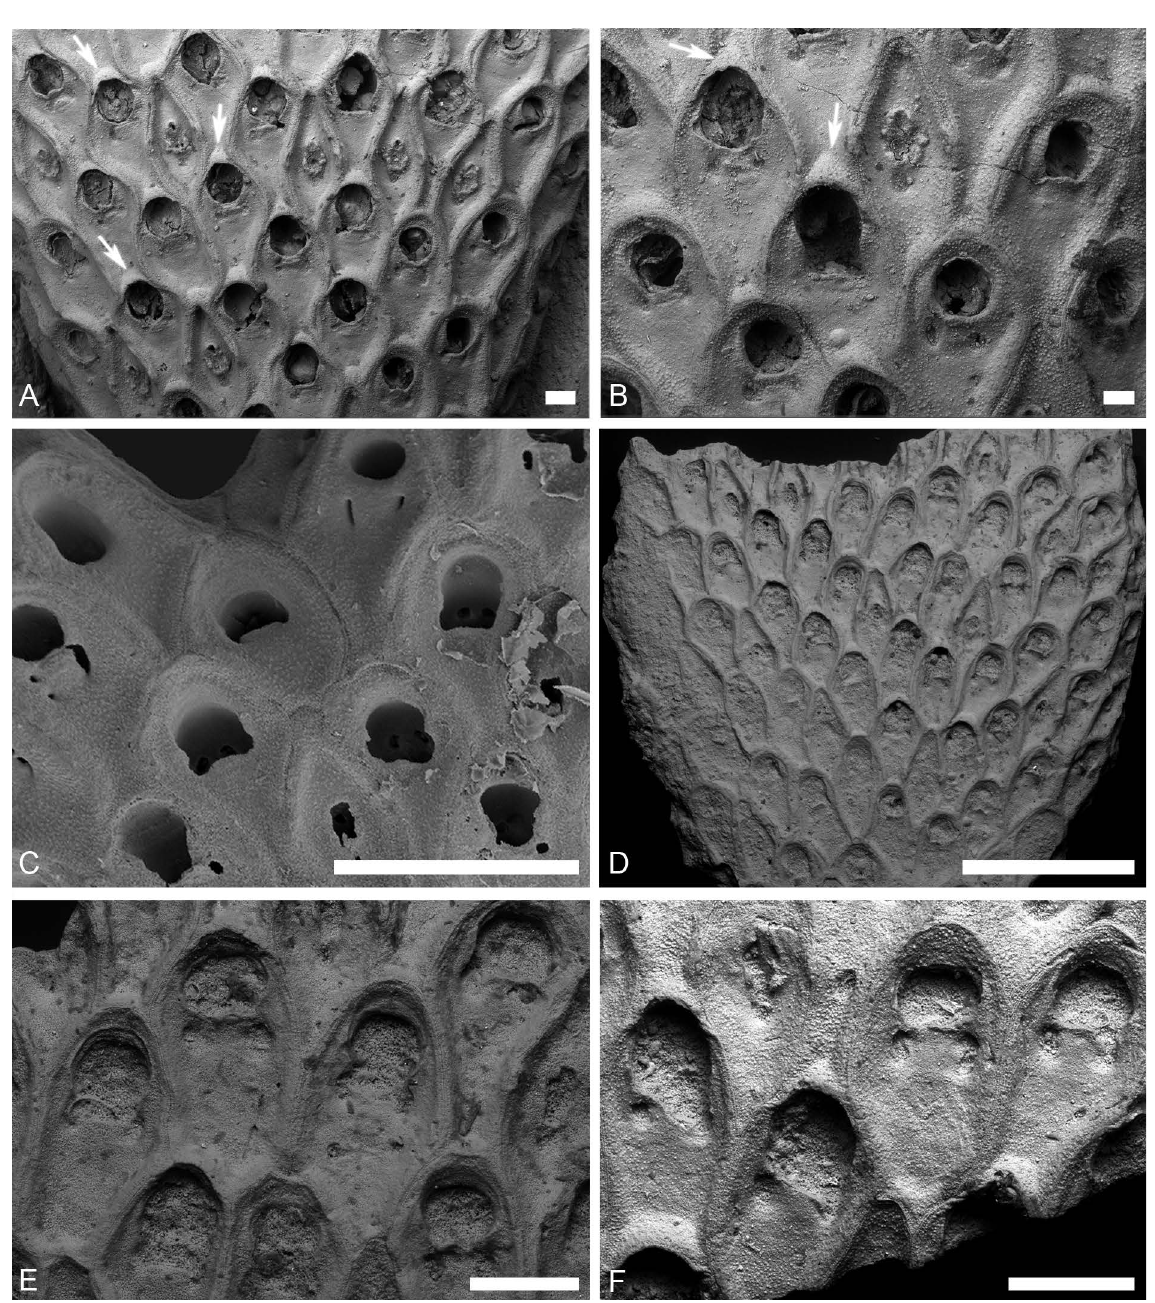
Fig. 19. Rhagasostoma mimosa (Brydone, 1930). A–B . Lectotype, SM B36696, early Maastrichtian ( Ostrea lunata Zone), Porosphaera Beds of Trimingham, Norfolk, England, UK. A . Part of erect bifoliate colony showing ovicellate (some ooecia arrowed) and non-ovicellate autozooids and aviacularia. B . Detail of autozooids with opesiules and some with vestigial ooecia (arrowed), and avicularia. C . SMF 29923, early Maastrichtian, Island of Møn, Denmark, bifurcating colony showing autozooids some opesiules and avicularia. D–F . Early Maastrichtian of an unknown locality on the Mangyshlak Peninsula, Mangystau Region, Kazakhstan. D–E . PIN 5502/3057. D . Part of erect bifoliate colony showing autozooids and aviacularia. E . Detail of autozooids with opesiules and avicularia. F . PIN 5502/3056, autozooids with opesiules and avicularia. Scale bars: A = 200 µm; B = 100 µm; C = 1 mm; D = 2 mm; E–F = 500